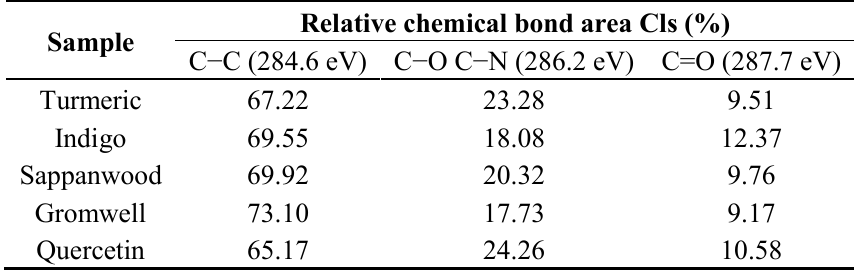
Table 4. Relative concentration of C1s components for silk fabric dyed with plant